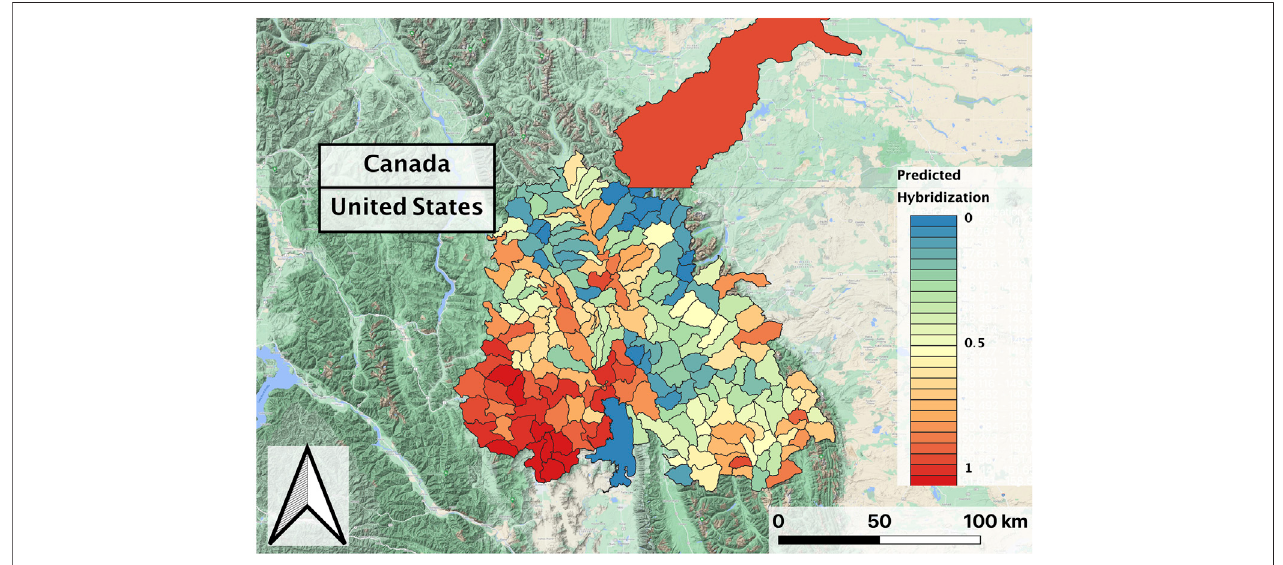
FIGURE 4 | Top predictors of RBT occurrence as identi fi ed by the occurrence model.